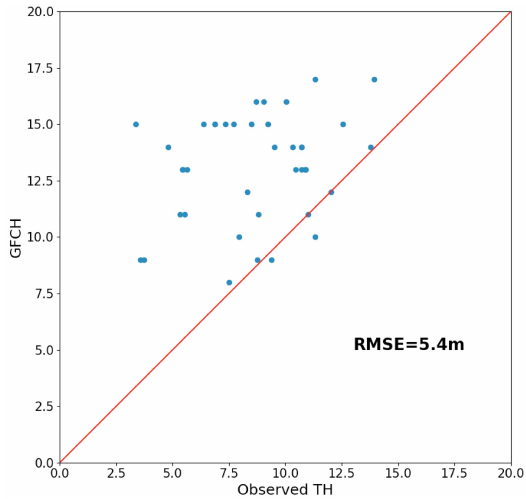
Figure 3. Comparison of measured TH and that obtained from GFCH. GFCH was overestimated compared to the measured TH. The RMSE was 5.4 m.